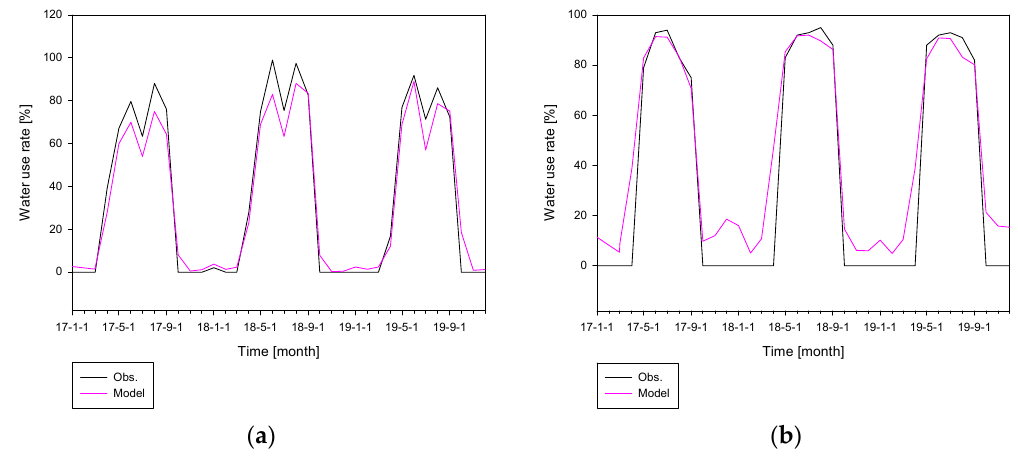
Figure 9. Comparison between the observed and estimated WUR. ( a ) At st. 926; ( b ) At st. 976.